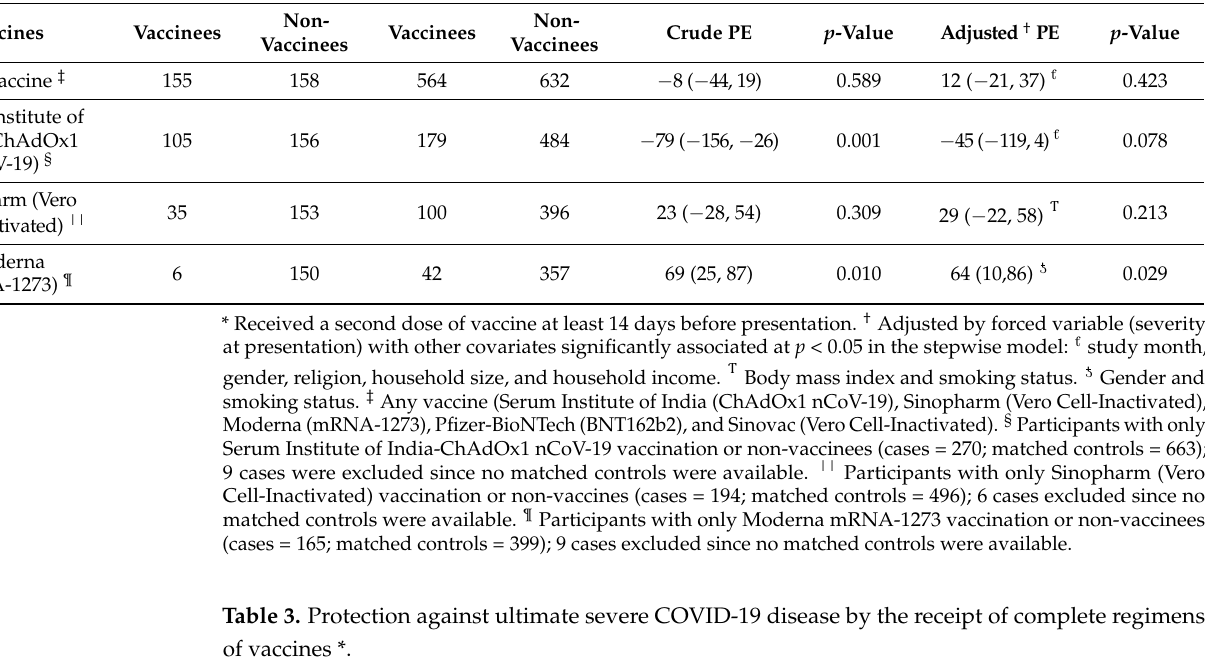
Table 2. Protection against any symptomatic COVID-19 disease by the receipt of complete regimens of vaccines *.